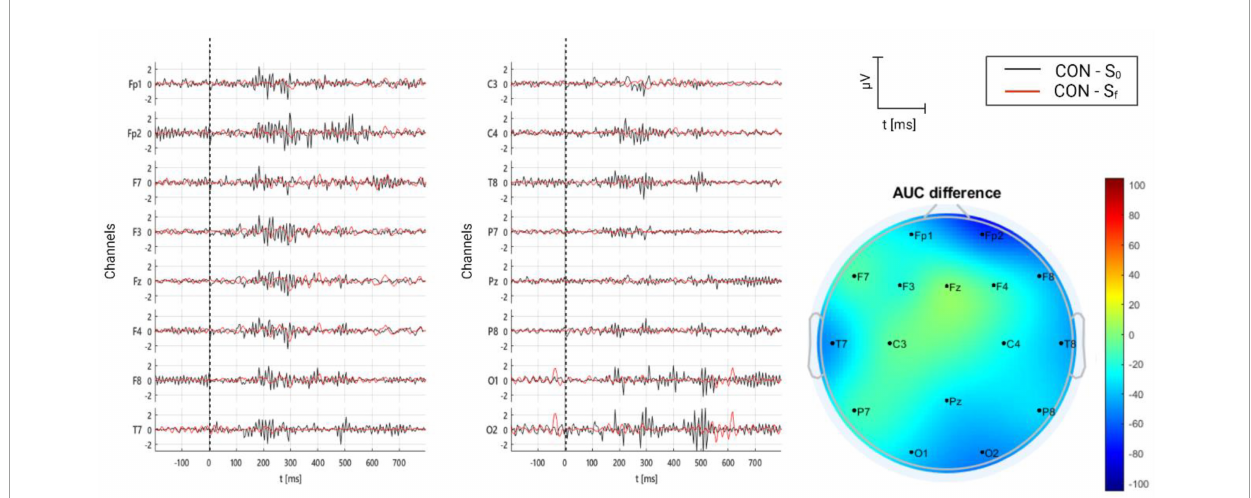
FIGURE13 Grand average of AERPs at S 0 (initial session) and S f (final session) for control group (healthy individuals using relaxing music). In addition, the AUC difference of these two grand averages (S f – S 0 ) is topographically plotted in µ V.